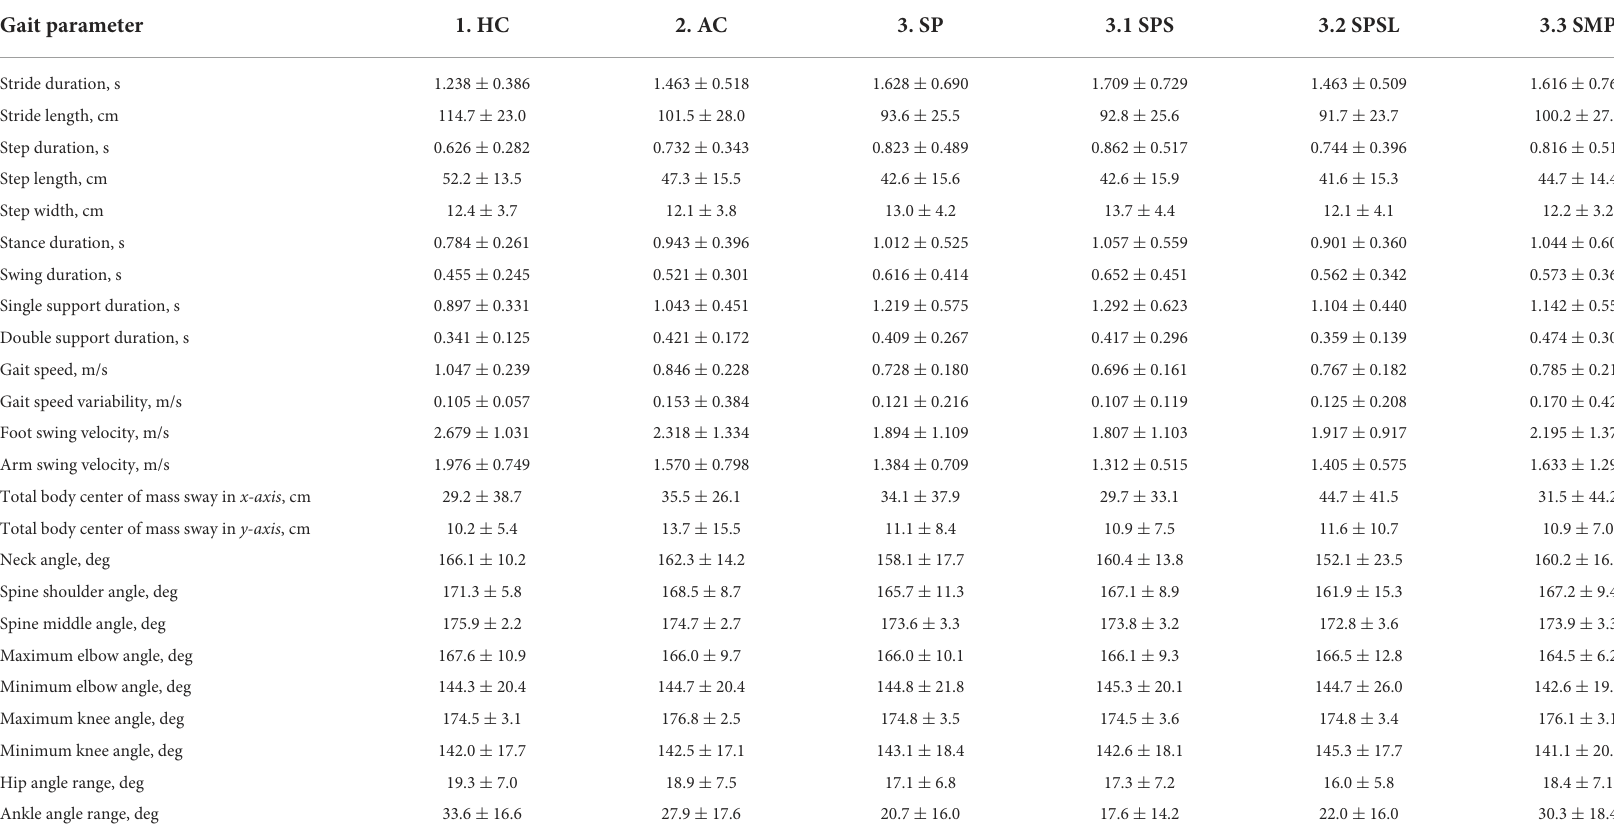
TABLE 2 Mean ± standard deviation values for each gait parameter and each subject group (1. Healthy Controls – HC; 2. Asymptomatic Carriers – AC; 3. Symptomatic Patients – SP; 3.1 Patients with small-fiber sensory polyneuropathy – SPS – and 3.2 with large-fiber sensory polyneuropathy – SPSL; and 3.3 Patients with motor neuropathy –